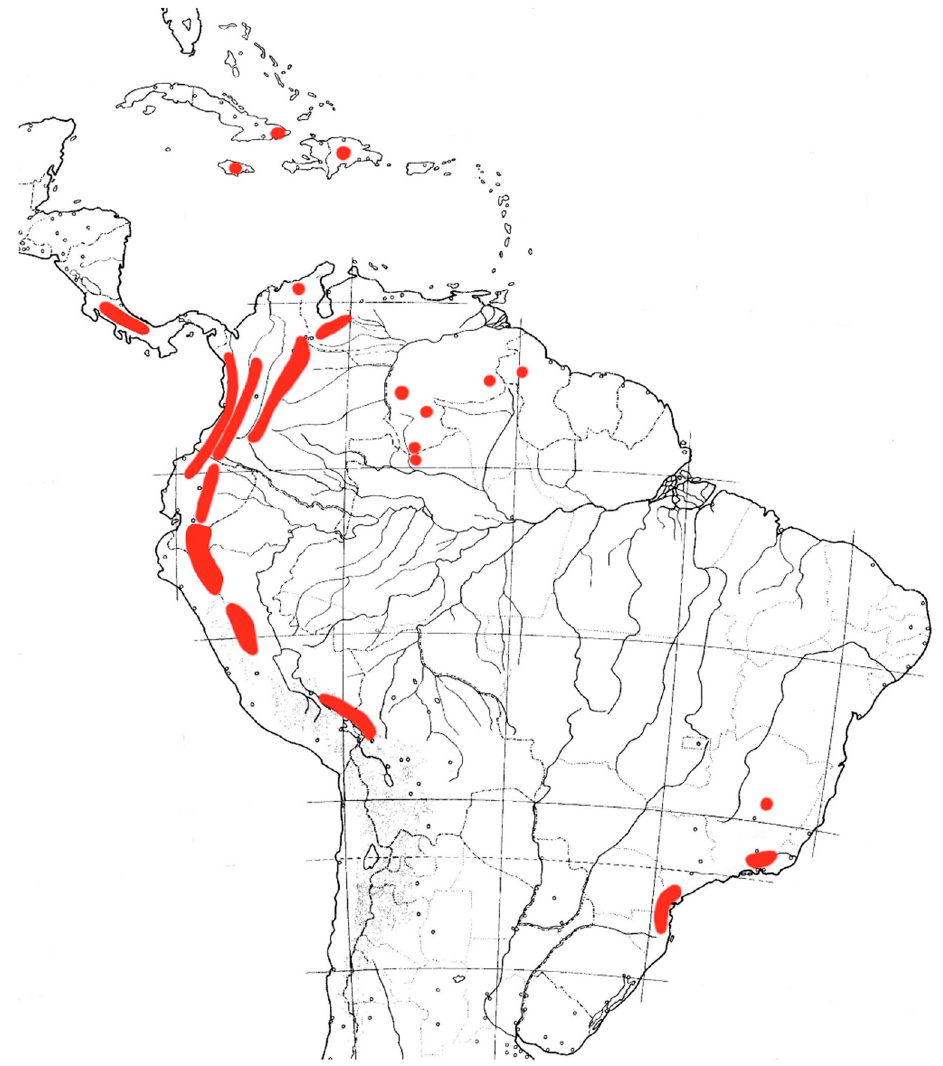
Figure 2. The map shows the known distribution of the plant genus Macrocarpaea in the Neotrop ‐ ics—in